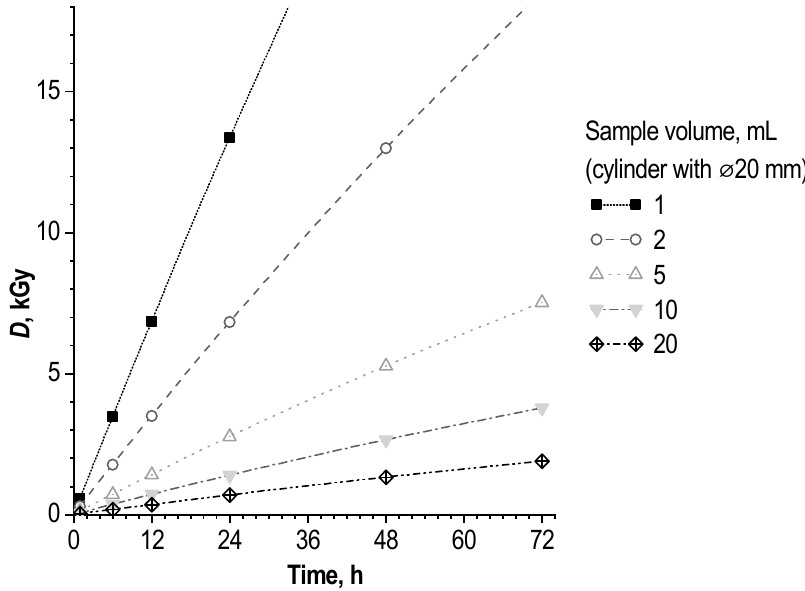
Figure 7. Dependence of absorbed dose growth over time on the volume of the sample (for 7.4 GBq of 177 Lu, aqueous solution in the geometry of a cylinder with a diameter of 20 mm, Gent4 simula- tion).